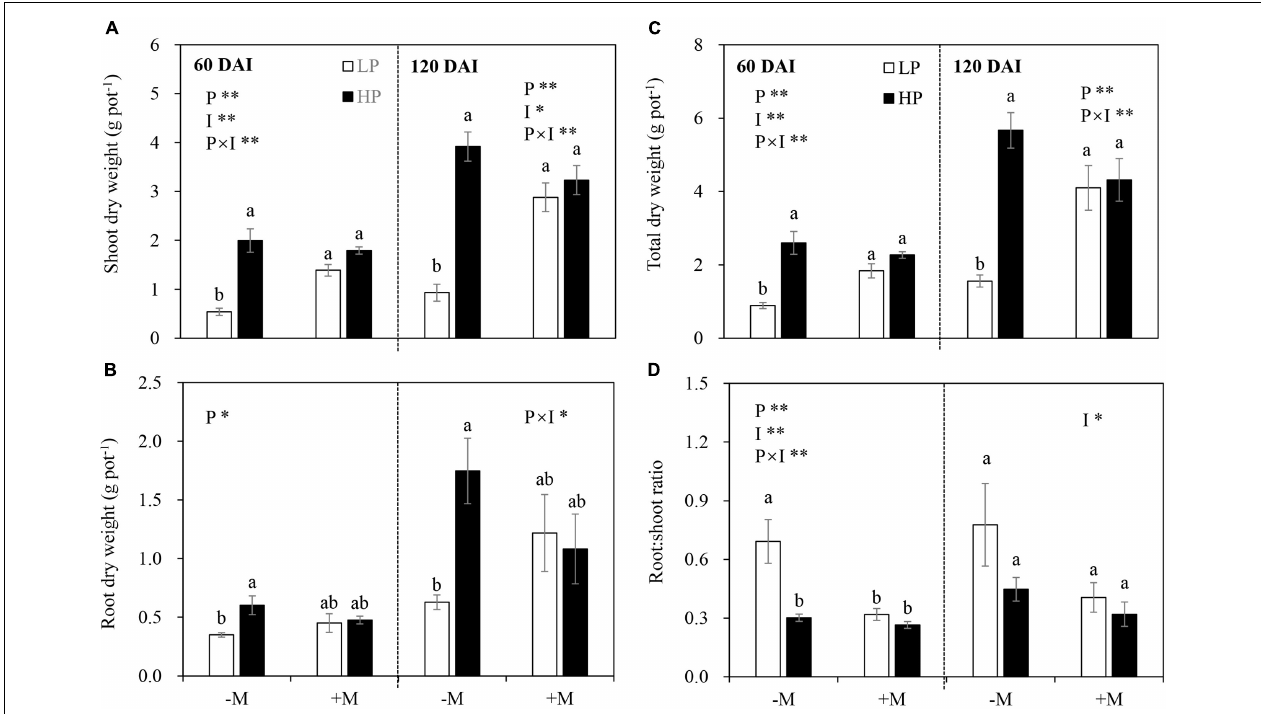
FIGURE 2 | (A) Shoot dry weight, (B) root dry weight, (C) total dry weight, and (D) root:shoot ratio as affected by soil P levels (P) and mycorrhizal status (I) 60 and 120 days after inoculation (DAI). –M and +M represent non-AM and AM inoculation with Rhizophagus irregularis , respectively. LP and HP represent 30 and 170 mg kg − 1 P application, respectively. Data are presented as mean ± standard error (SE, n = 4). Treatment effects were tested by two-way ANOVA separately between the two harvests. ∗ P < 0.05; ∗∗ P < 0.01. Multi-comparison was performed across all treatments at the same harvest time, and the same letter indicates no significant difference between the means at P < 0.05 by Turkey’s HSD